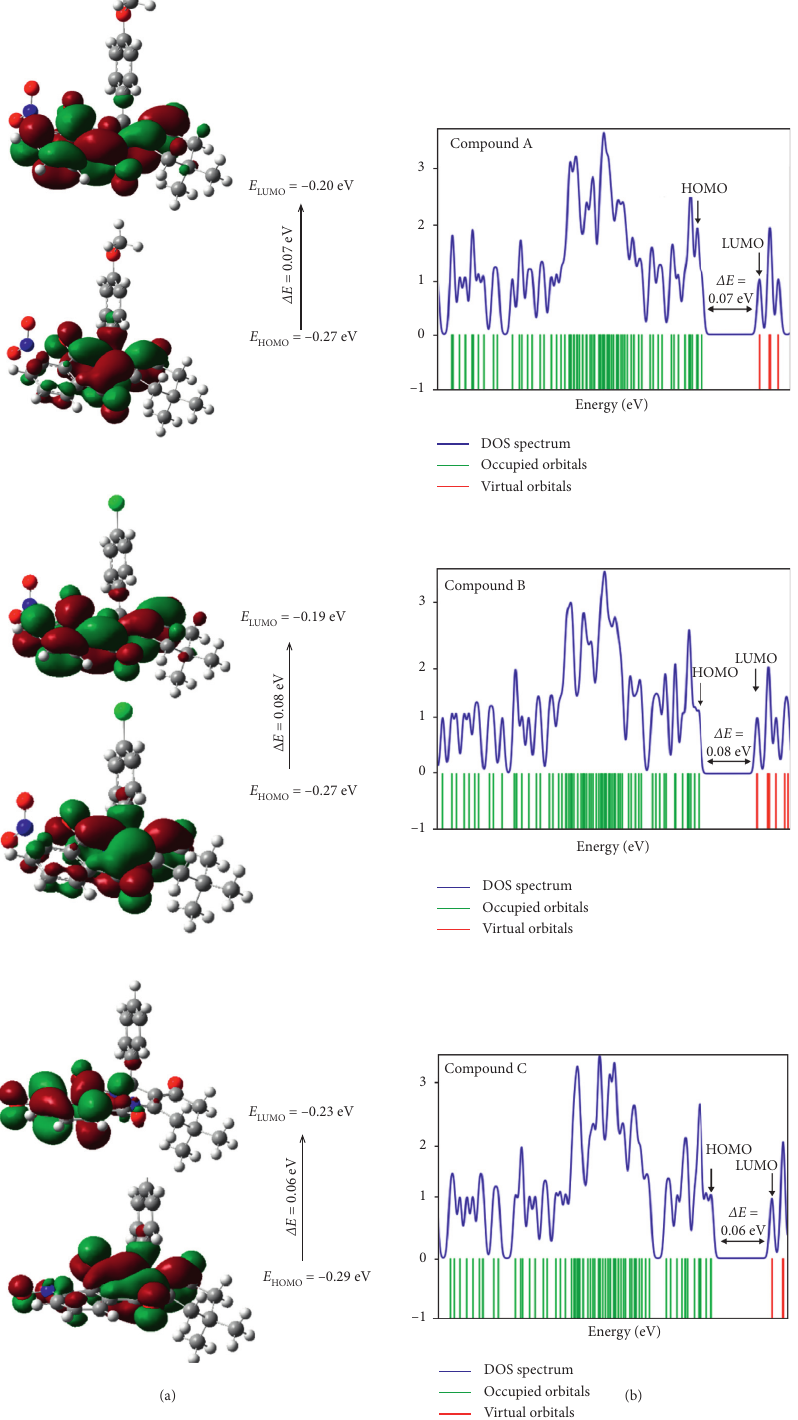
Figure 1: (a) Calculated frontier molecular orbitals of compounds 5a , 5b, and 5c ( Δ E: energy gap between LUMO and HOMO). (b) Calculated DOS plots of the title compounds (using 3.1.2. 3,3-Dimethyl-10-nitro-13-phenyl-2,3,4,13-tetrahydro- 1H-indazolo[1,2-b]phthalazine-1,6,11(13H)-trione (5b) . Yellow solid; m.p. > 250 ° C; Yield: 80%; Anal. Calcd for C H N O (417.4): C, 66.18; H, 4.59; N, 10.07 %. Found: C, 23 19 3 5